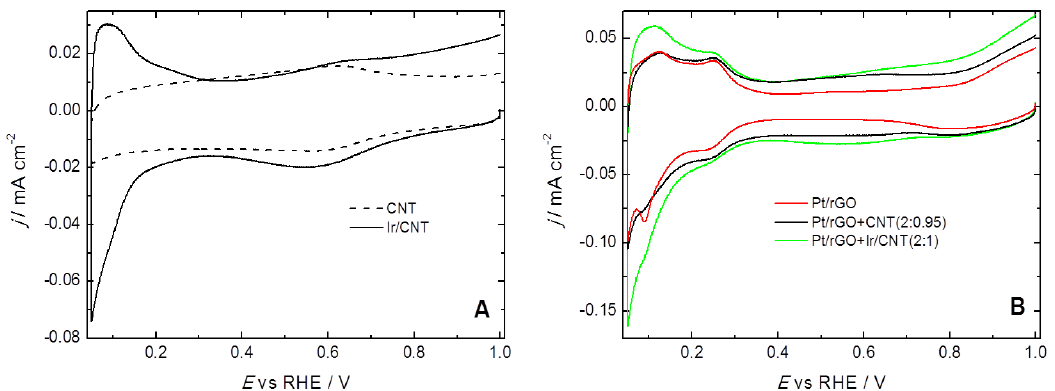
Figure 4. Cyclic voltammetric responses recorded for catalytic films (deposited on glassy carbon disk of RRDE assembly) of CNT and Ir/CNT ( A ) and Pt/rGO, Pt/rGO+CNT(2:0.95) and Pt/rGO+Ir/CNT(2:1) ( B ). Electrolyte: nitrogen-saturated 0.5-mol dm − 3 H 2 SO 4 ; scan rate: 10 mV s − 1 .